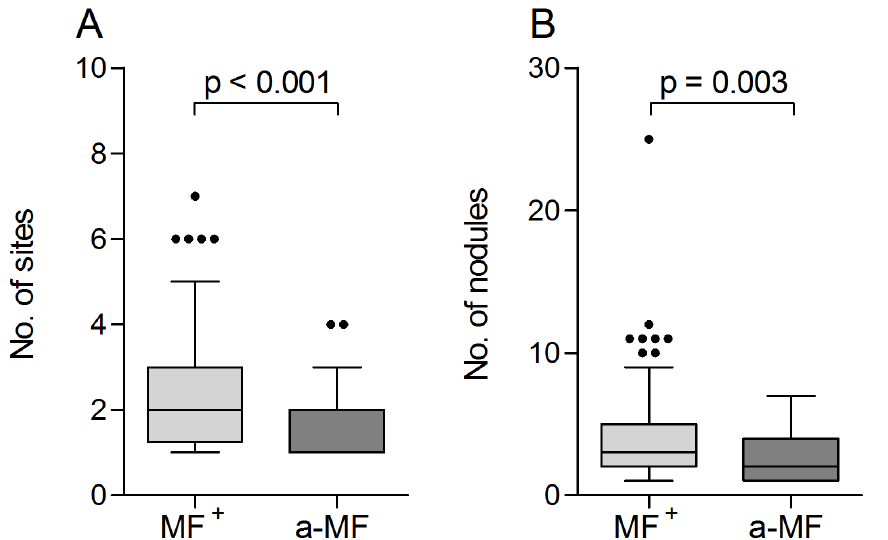
Figure 1. O.volvulus infections are characterized by the presence of nodules in the skin. MF + (n=164) and amicrofilaridermic (a-MF, n=46) individuals were examined for the number of sites (A) and the number of nodules (B) by palpation. Graphs show box whiskers with median, interquartile ranges and outliers. As indicated, statistical significances between the groups were obtained using Mann-Whitney tests.